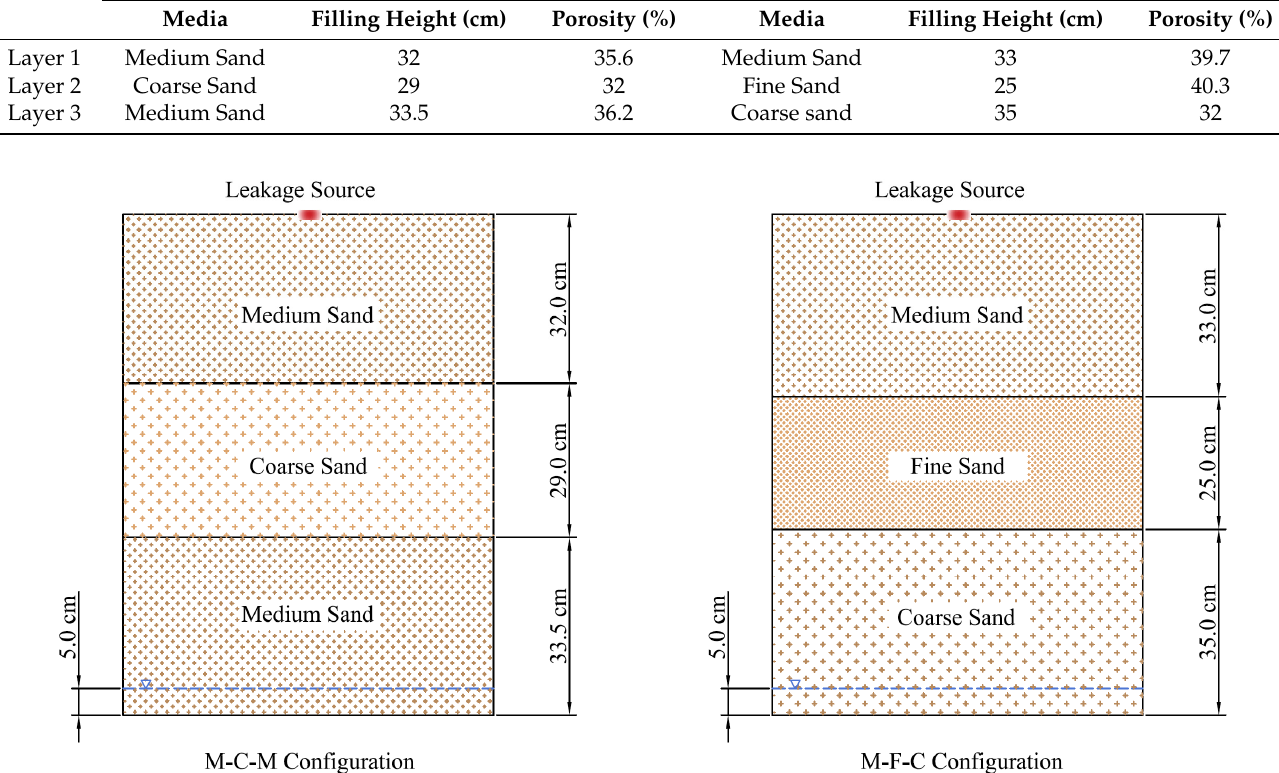
Figure 2. Schematic diagram of soil media structures. Table 3. Media configurations of the sand tank.